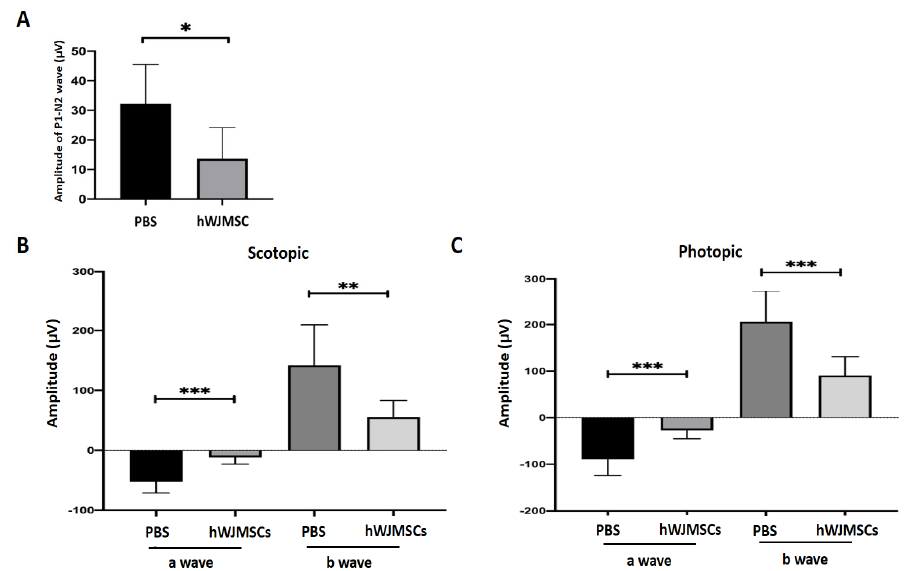
Figure 2. Evaluation of visual function and retinal function through flash visual-evoked potential (FVEP) and electro- retinogram (ERG) recordings. ( A ) Bar chart showing the P1-N2 amplitudes in the PBS-treated group and in the hWJMSC group. A significant decrease of P1-N2 amplitude was found in the hWJMSC-treated group as compared to that in the PBS-treated group ( p < 0.05, n = 12). Data are expressed as mean ± SD. P1, P1 the first positive peak; N2, the second nega- tive peak. ( B ) Recordings of scotopic and ( C ) photopic ERG analysis revealed the amplitudes of a- and b-wave in the PBS-treated group and the hWJMSC-treated group. Both visual electrophysiology data showed that the amplitudes of a- and b-waves were significantly reduced by hWJMSC treatment compared to the PBS treatment. Data are expressed as mean ± SD.* p < 0.05; ** p < 0.01; *** p < 0.001.